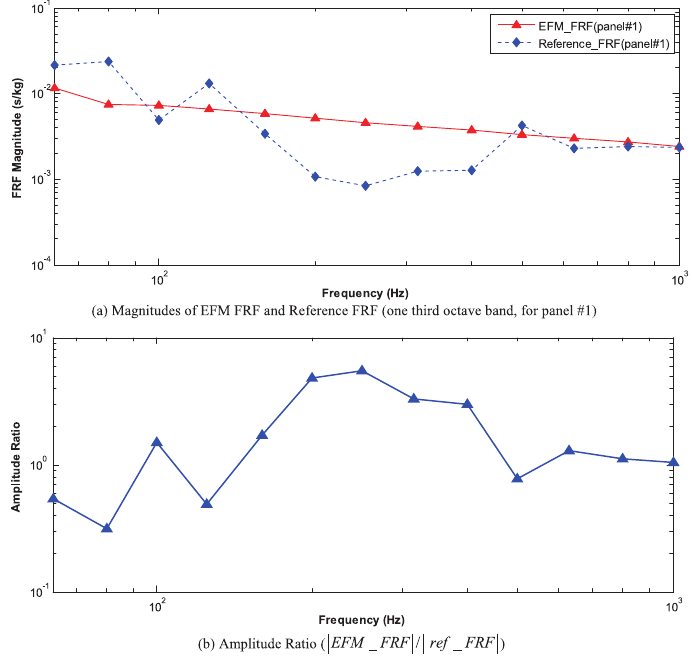
Fig. 15. Amplitude ratio calculation by EFM FRF and reference FRF (typical, for panel